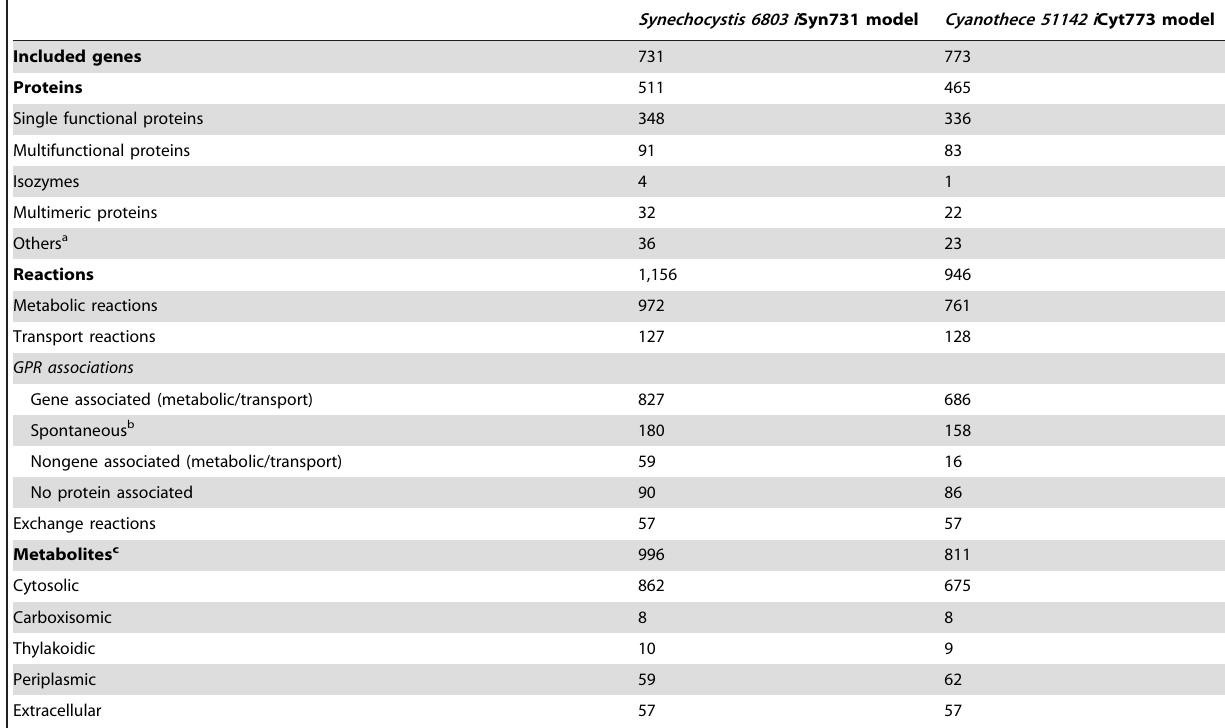
Table 1. Synechocystis 6803 i Syn731 and Cyanothece 51142 i Cyt773 model